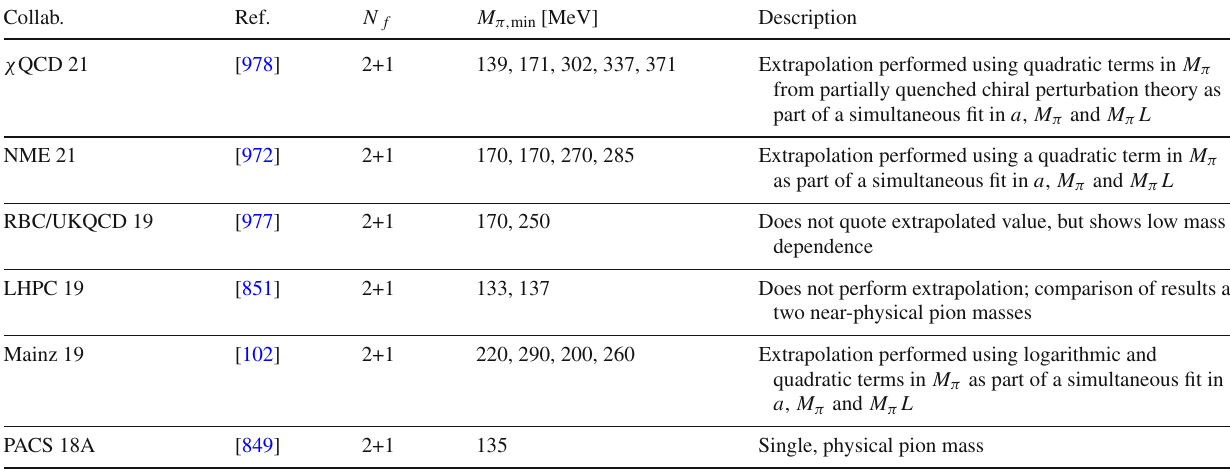
Table 177 Chiral extrapolation/minimum pion mass in determinations of the isovector axial, scalar and tensor charges with N f = 2 + 1 quark flavours Collab.